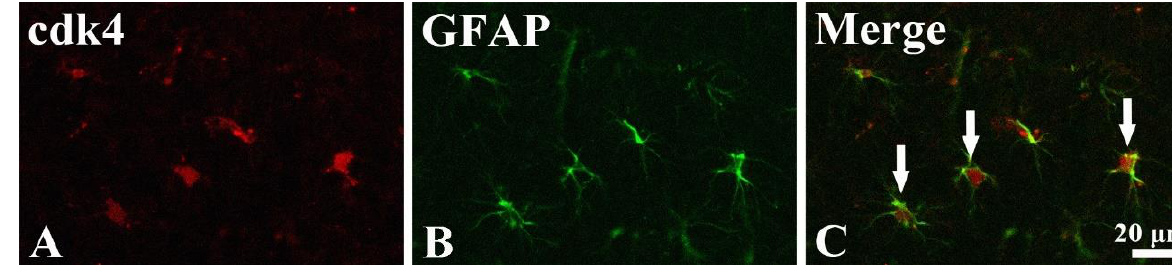
Figure 5. Double immunofluorescence for cdk4 (( A ); red), GFAP (( B ); blue), and merged image ( C ) in the stratum radiatum at 5 days after TI. Cdk4 immunofluorescence is co-localized with astrocytes (white arrows in ( C )) which are immunostained with GFAP. Scale bar = 20 μm.